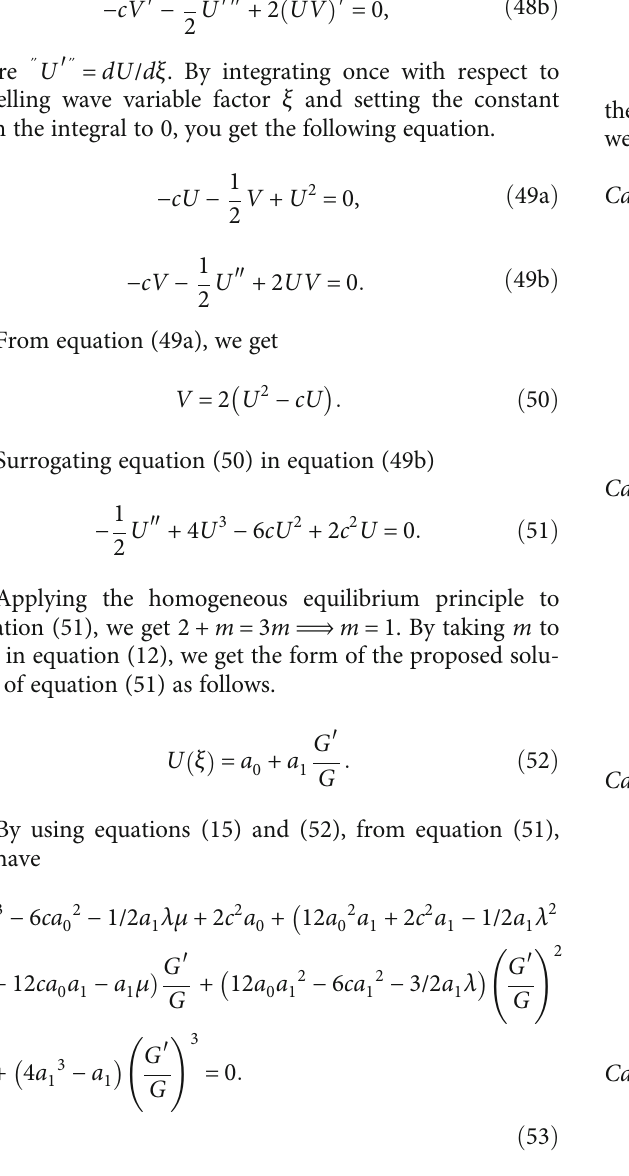
ffiffiffiffiffiffiffiffiffiffiffiffiffiffiffi λ 2 − 4 μ